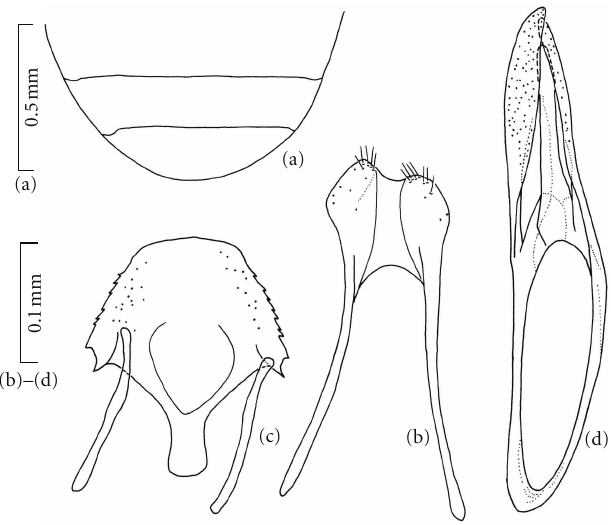
Figure 9: Hydrocyphon klapperichi sp.n., holotype, male. (a) Sternites V–VII; (b) tergite IX; (c) tegmen; (d) penis.